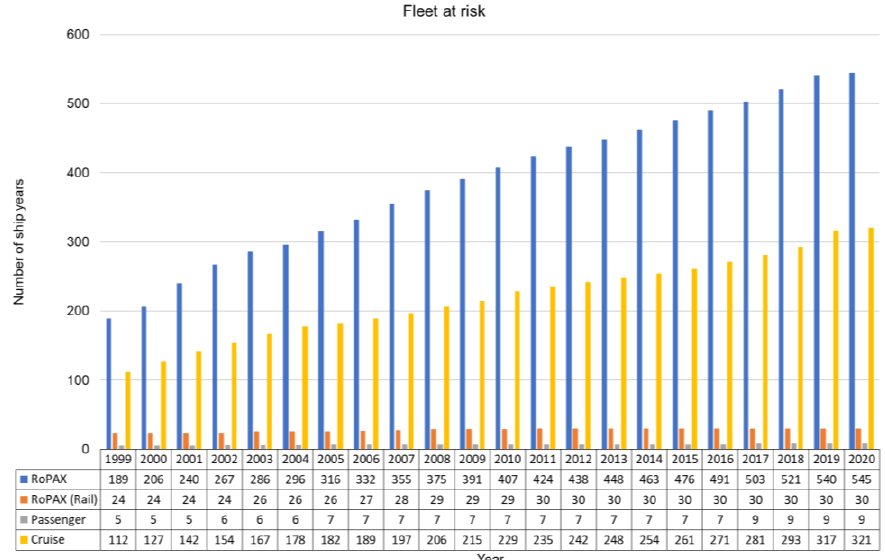
Figure 14. Yearly distribution of the number of fleets registered for different types of passenger ships. Table 1. Initial accident frequencies of RoPax and cruise ships for different accident types. Accident Type No. of Casualties